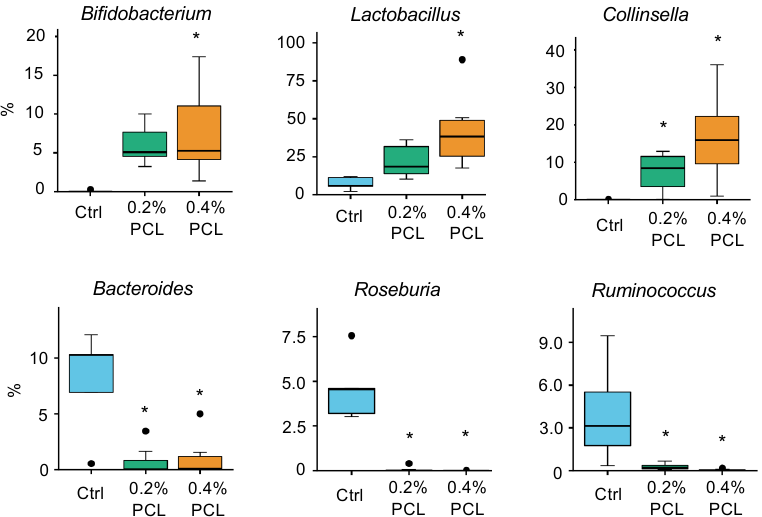
Figure 4. Effects of supplemental PCL on cecal microbiota composition at the genus level (% of total bacteria). * p < 0.05 means significantly different when compared to the Ctrl group (Dunnett’s test). Data are presented as a boxplot with median and min–max whiskers. The dots ( • ) in the boxplots are